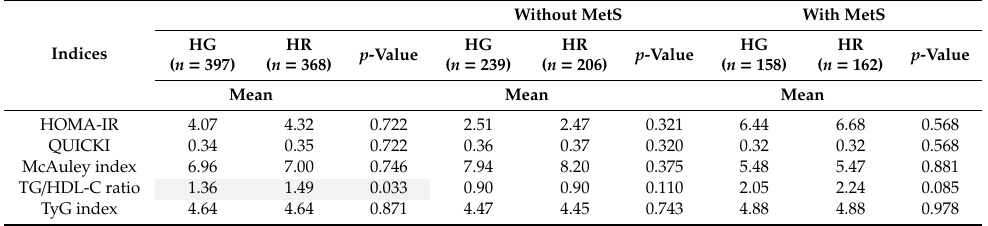
Significant di ff erences are highlighted in grey.